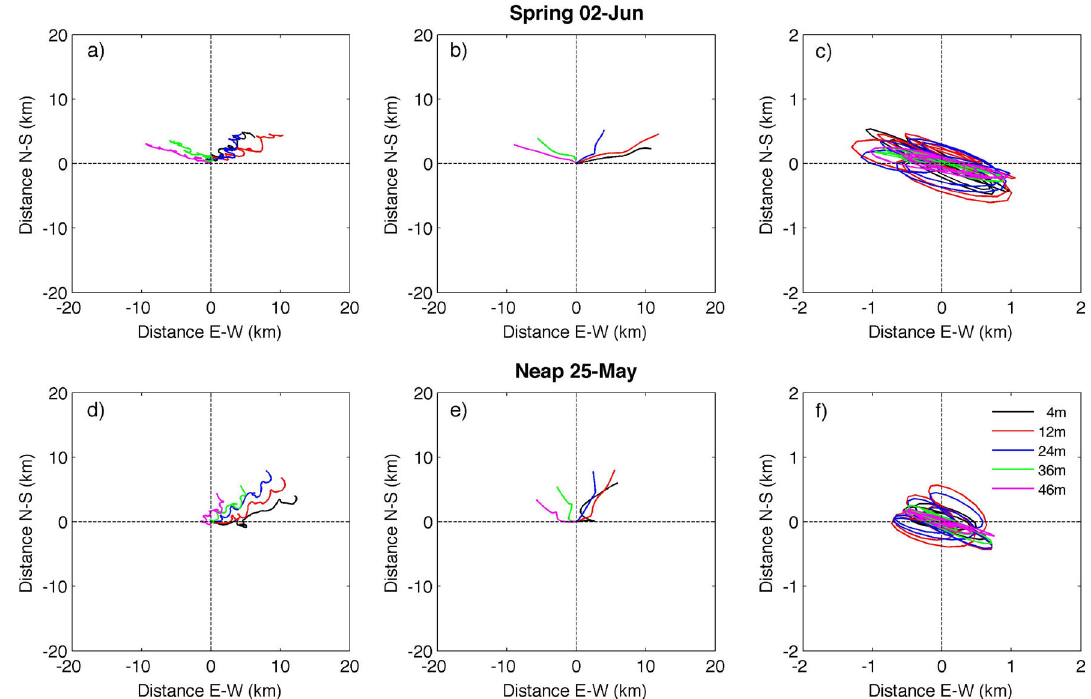
Fig. 8. Progressive vector diagrams constructed using 3 d of (a,d) total currents, (b,e) residual currents and (c,f) tidal currents: (a−c) during spring tides, beginning on 2 June 2011 and (d−f) during neap tides, beginning on 25 May 2011. Colors